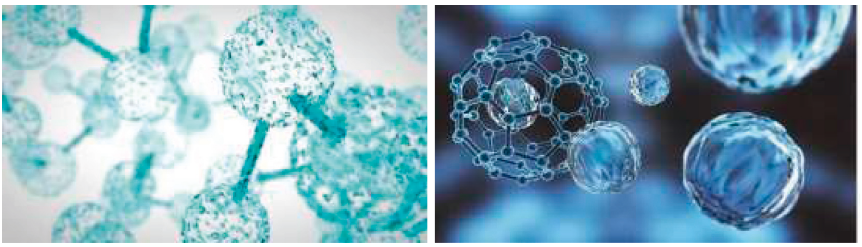
Figure 1: Nanoparticle map.